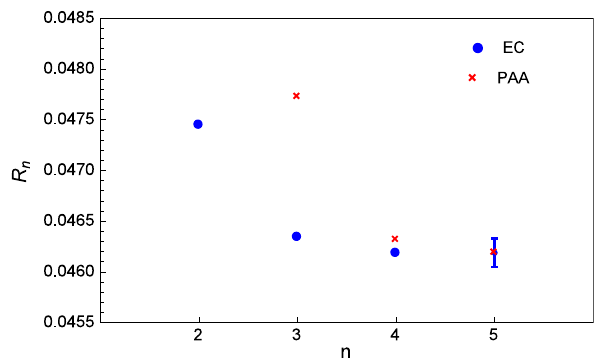
Fig. 1 Comparison of the exact (“EC”) and the predicted ([0/n-1]-type “PAA”) pQCD prediction for R n ( Q = 31 . 6 GeV ) under the PMC-s scale-setting. It shows how the PAA predictions change when more loop-terms are included, where the five-loop “EC” prediction is from Eq.